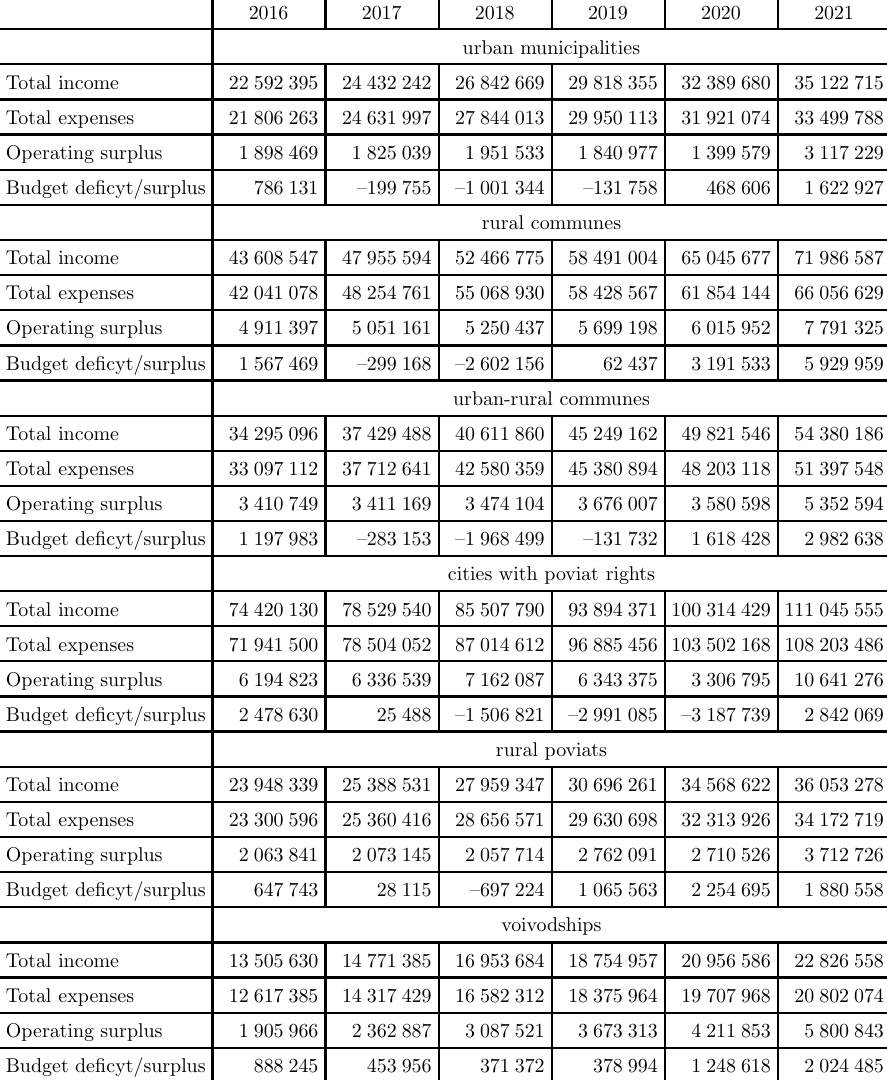
Budget data of local government units in 2016–2021, [in